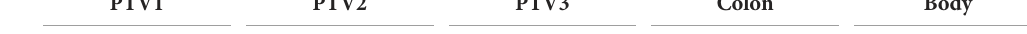
TABLE 6 Absolute difference of target and OARs DVH dosimetric parameters of the original CT and of the reworked CT vs. the corresponding syCT plans.